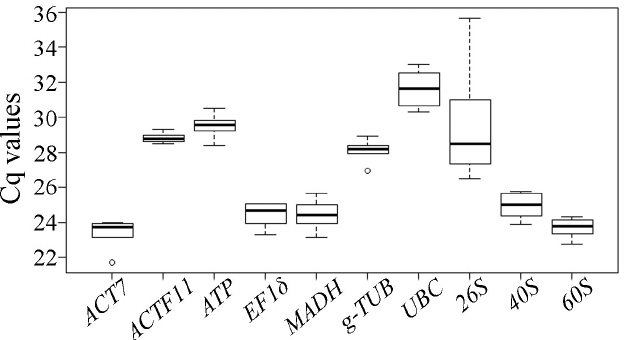
Figure 2. qRT-PCR cycle threshold (Cq) values of 10 candidate reference genes from all investigated samples. The lines across the box indicate the median values, boxes indicate the 25/75 percentiles, whisker caps indicate the maximum and minimum values, and small circles represent outliers. The higher boxes and whiskers indicate the greater the